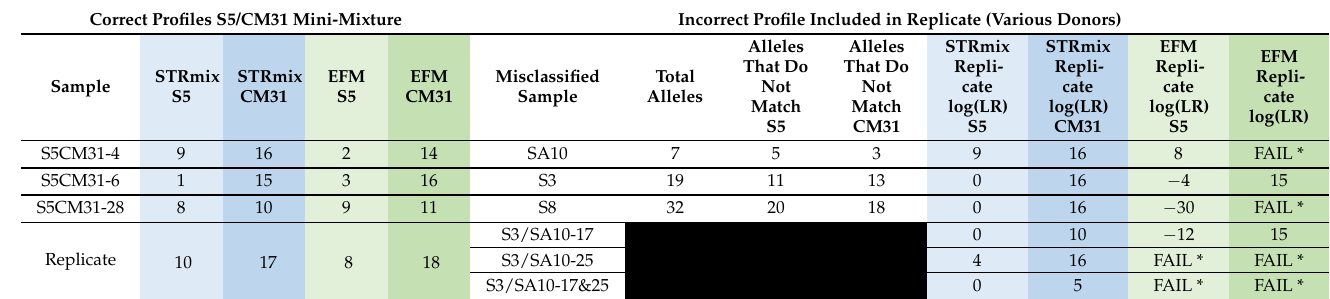
Table 6. Misclassification of mini-mixtures for replicate